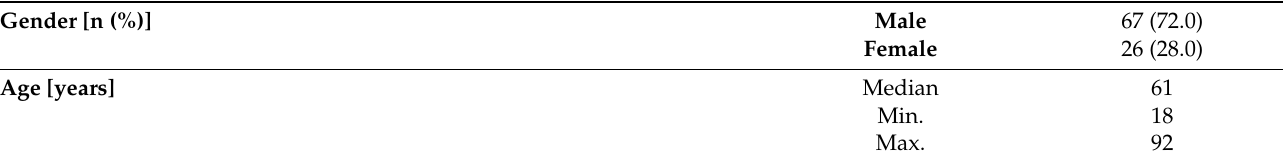
Table 1. Characteristics of patient